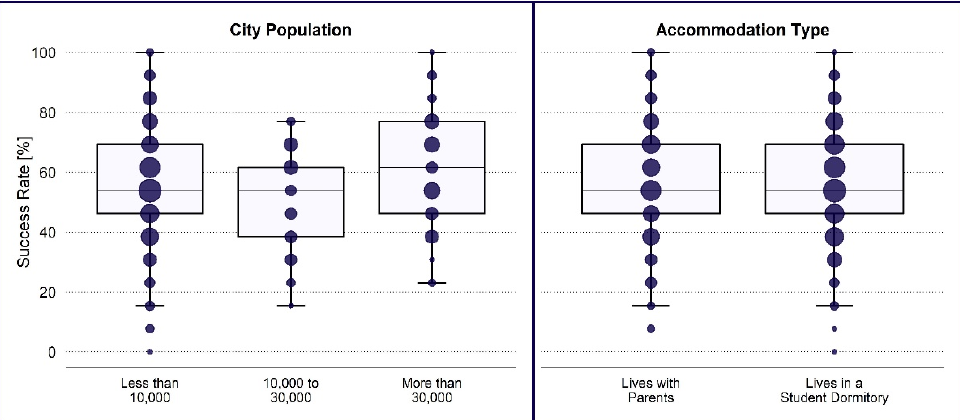
Figure 5. Success rate of students in the financial literacy test depending on the demographic factors.